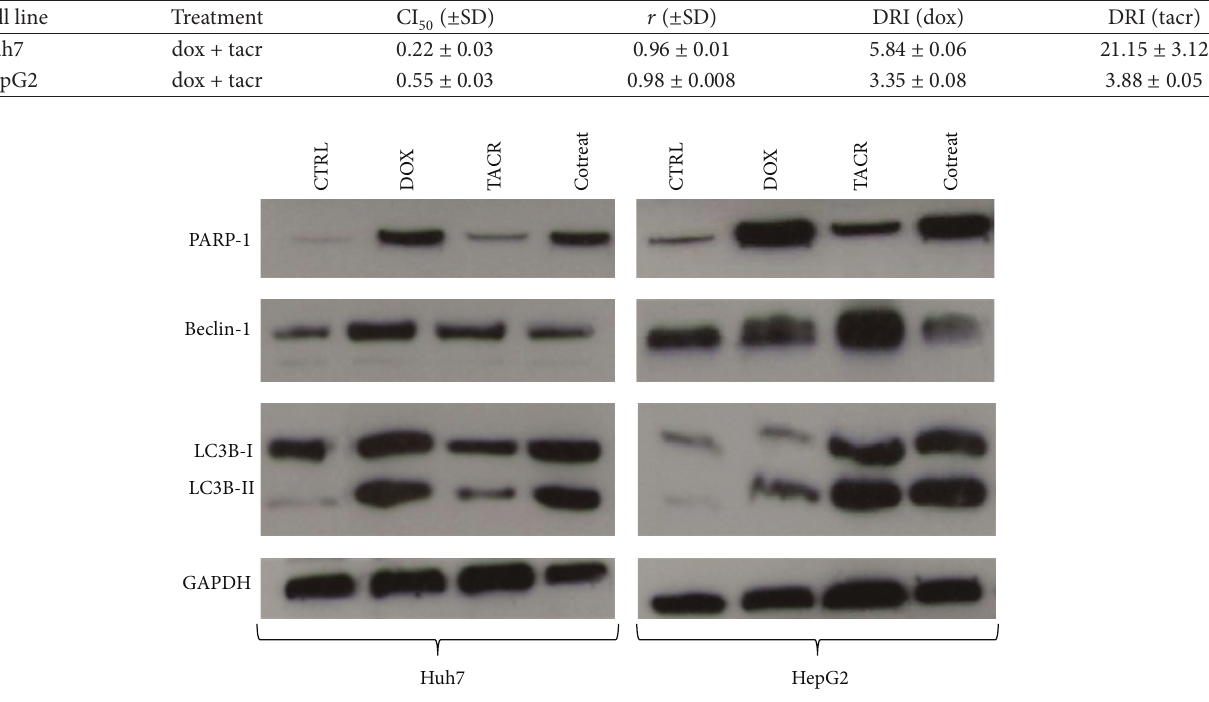
Figure 3: PARP-1 cleaved, Beclin-1, LC3I, and LC3II protein expression analysis by western blotting in Huh7 and HepG2 cell lines after treatment with doxorubicin (0.85 𝜇 M) and tacrolimus (0.052 𝜇 M) and cotreatment (0.42 𝜇 M dox plus 0.026 𝜇 M tacr). GAPDH was used as loading control.